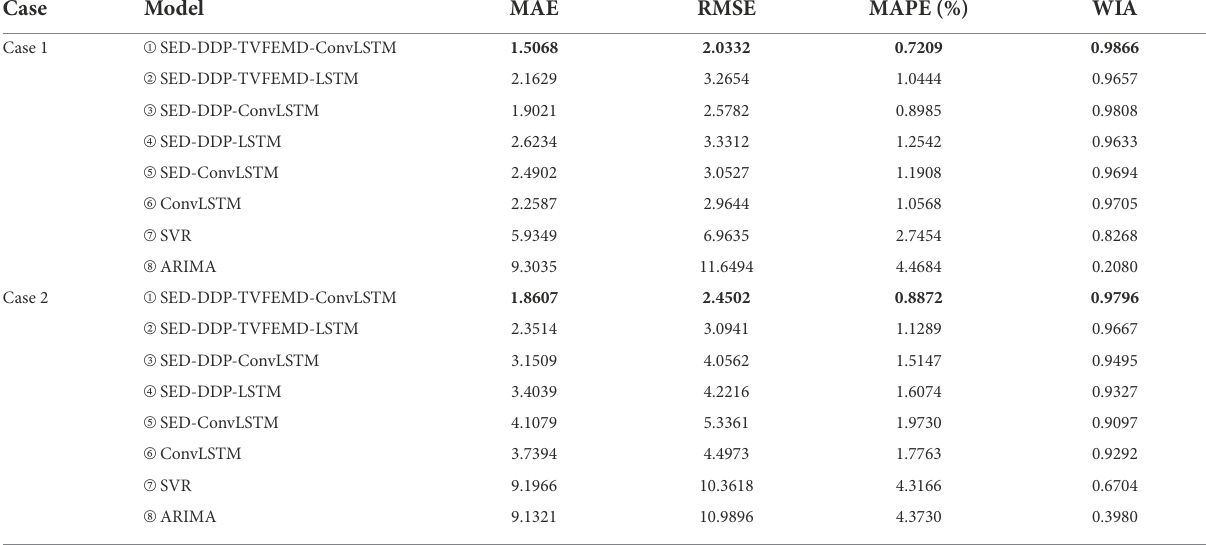
TABLE 2 Prediction results of all the